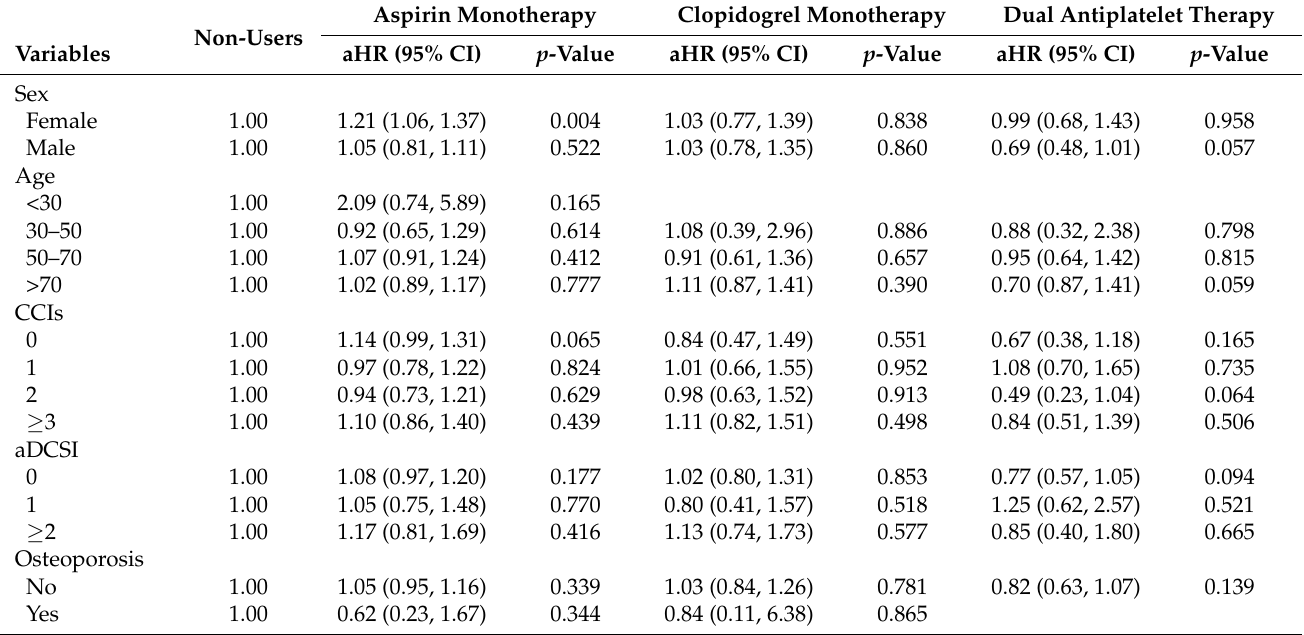
Table 3. Risk of hip fracture in different subgroups.